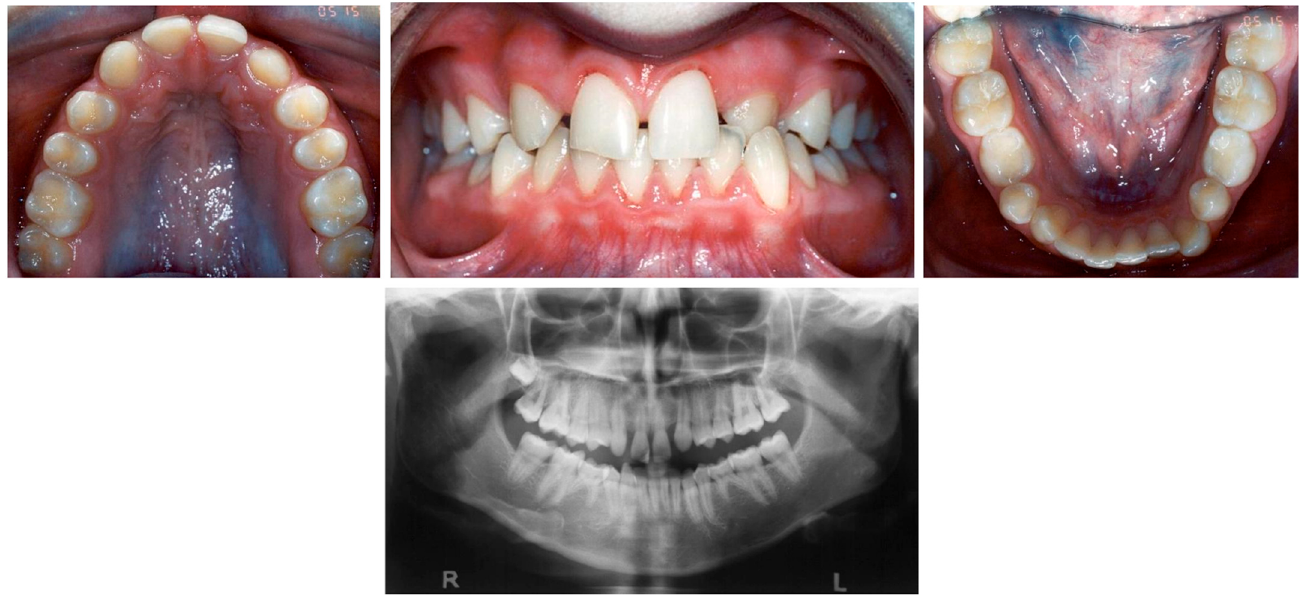
Figure 4. Pre-treatment photographs of a 14-year-old male with congenitally missing maxillary lateral incisors, and mandibular second premolars, retained mandibular second deciduous molars, cross bite between the maxillary and mandibular left canines, and minor mandibular anterior crowding.